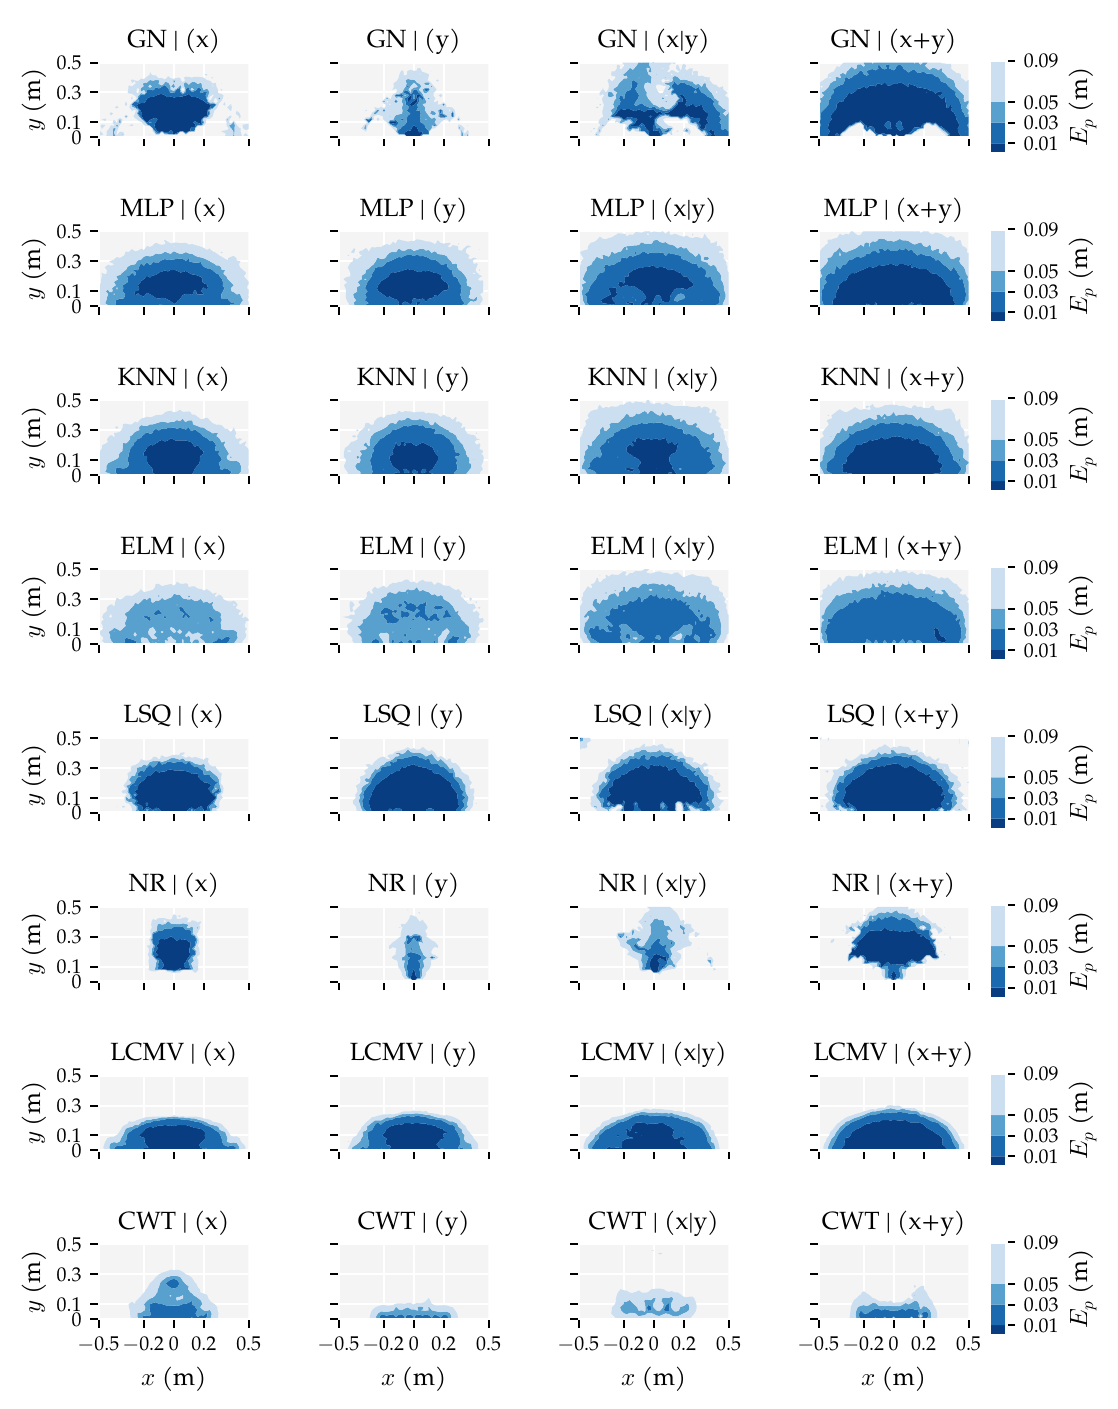
Figure A8. Spatial contours of the median position error (Equation (4)) for each localisation algorithm in all conditions of Analysis Method 2. This analysis varied the sensitivity axes of the sensors: (x + y) measured both velocity components at all sensors, (x|y) alternated measuring v x and v y for subsequent sensors, (x) measured only v x at all sensors, (y) measured only v y at all sensors. The D s = 0.01 training and optimisation set and σ = 1.0 × 10 − 5 ms − 1 noise level were used. The median position error was computed in 2 × 2 cm 2 cells. The sensors were equidistantly placed between x = ± 0.2